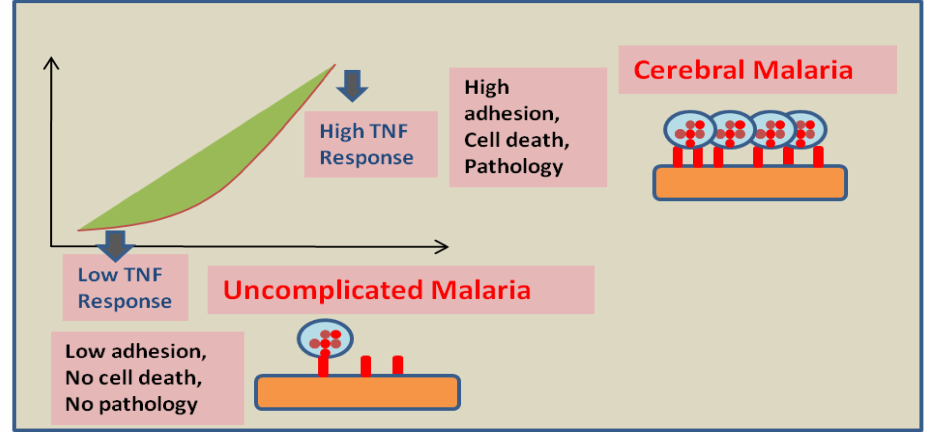
Figure 2. Proposed effect of the host endothelial response to TNF on disease severity: Low endothe- lium response to TNF leads to a minimal adhesion of infected RBCs and host cells and might be responsible for the absence of pathology. However, high endothelium response to TNF leads to elevated adhesion of infected RBCs. Moreover, a strong pro-apoptotic signal is generated in high responders that possibly results in BBB breakage and vasogenic edema (this figure is adopted and modified from Wassmer SC et al.